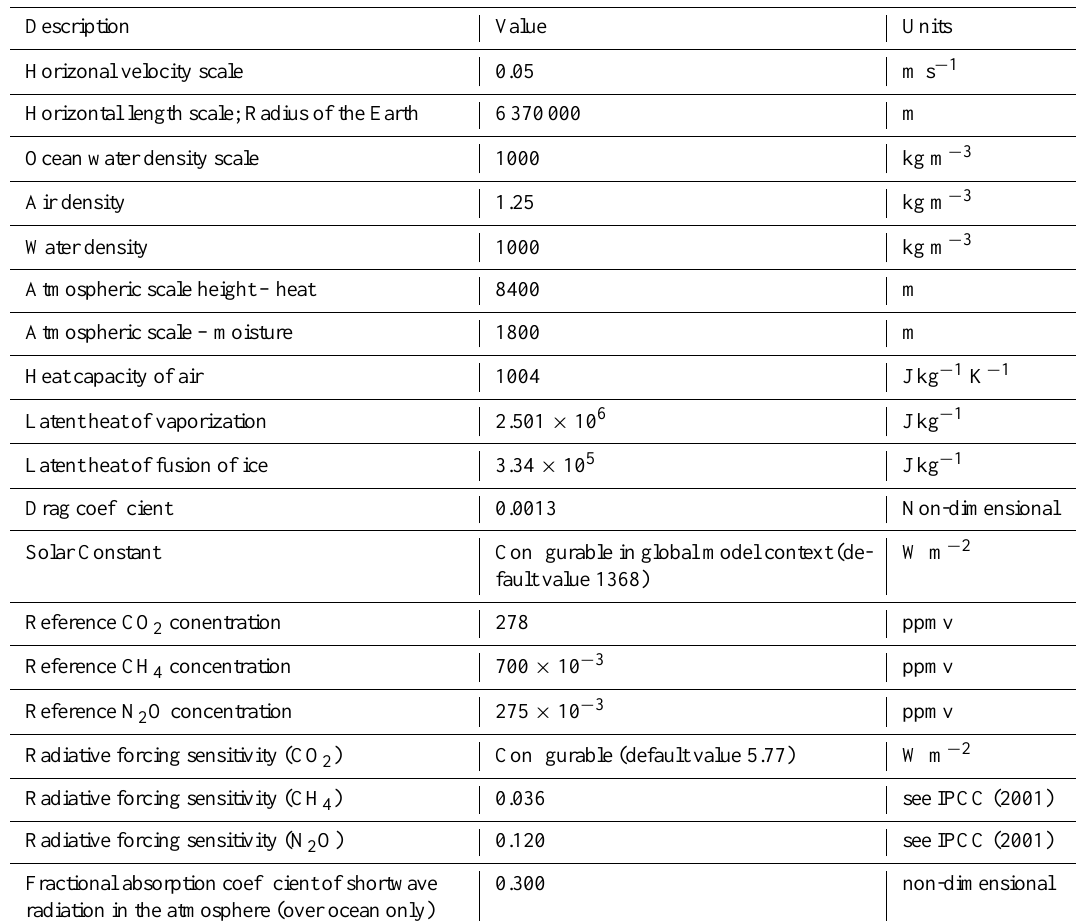
Table A2. : Dimensional scale values, constants, and some configurable parameters of the atmospheric model component (including a rudimentary land